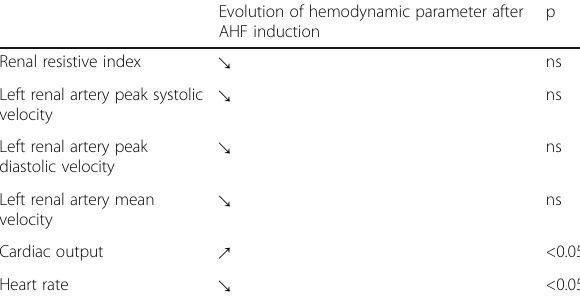
Table 1 (abstract 0009). Change of main cardiac and renal hemodynamics parameters after acute heat failure induction by isoproterenol in WT mice.